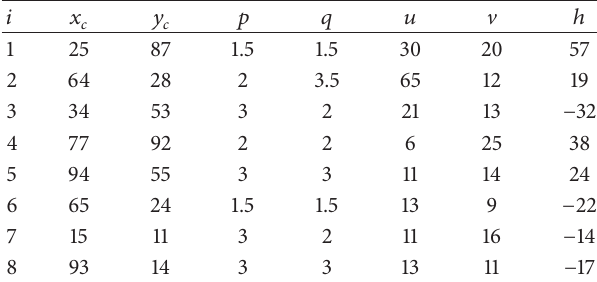
Table 1: Parameters of topographical